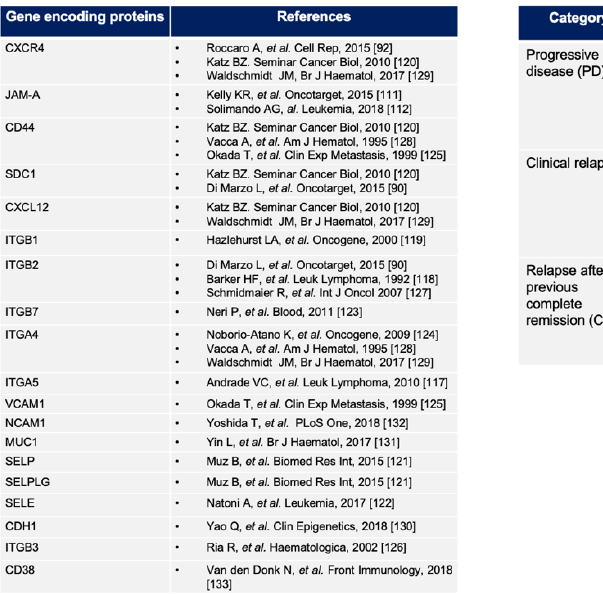
Figure 3. ( A ) Gene encoding protein list: adhesion molecule implicated in drug resistance described in MM (see the text and [117–133] for details); ( B ) definition of the disease relapse according to the International Myeloma Working Group (see the text for details). M protein: monoclonal protein.